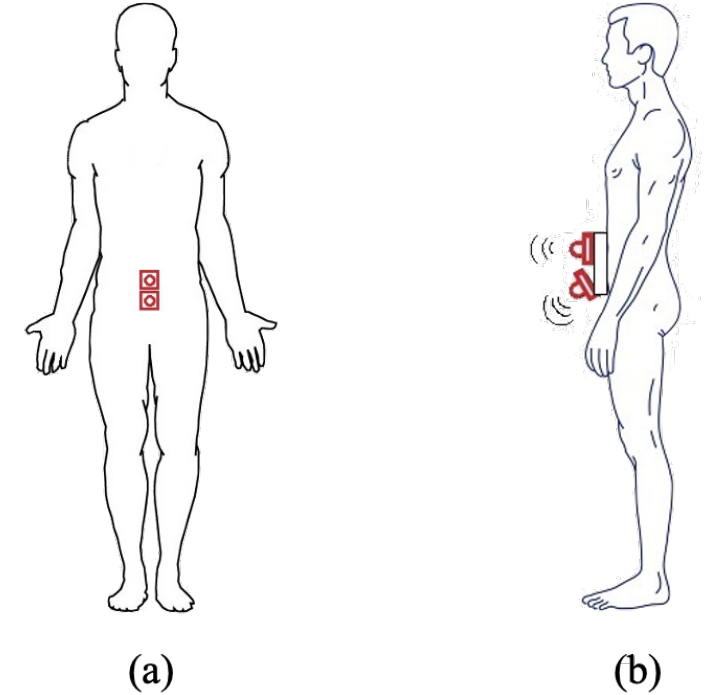
Figure 13. ( a ) Experimental configuration with ultrasonic sensors pointing straight ahead, used for interference evaluation among the sensors themselves. ( b ) Experimental configuration with two ultrasonic sensors, one pointing forward and one tilted